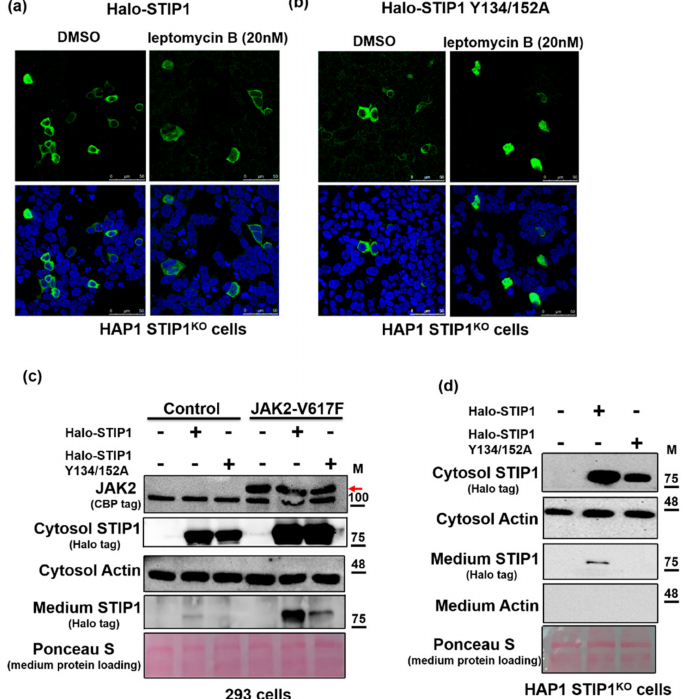
Figure 6. JAK2 regulates the intracellular localization and the extracellular secretion of STIP1. ( a , b ) Confocal microscopy was used to examine the intracellular localization of Halo-STIP1 ( a ) or Halo- STIP1 Y134/152A double mutant ( b ) in HAP1 STIP1 KO cells—either in presence or absence of leptomycin B (20 nM). Cells were probed with an anti-Halo tag antibody (green signal), whereas the nucleus was stained with DAPI (blue signal). ( c ) A control vector or the NTAP-JAK2 V617F vector were co-transfected with Halo-STIP1 or the Halo-STIP1 Y134/152A double mutant into HEK293 cells for 48 h. Protein levels of exogenous JAK2, exogenous STIP1, endogenous actin, and STIP1 in the culture medium were assessed with western blot. Ponceau S staining served as a loading control for STIP1 levels in the culture medium. The red arrow indicates the position of the JAK2 protein. ( d ) HAP1 STIP1 KO cells overexpressed wild-type STIP1 or the STIP1 Y134/152A double mutant for 48 h. Protein levels of exogenous STIP1, endogenous actin, and actin in the culture medium and STIP1 in the culture medium were assessed with western